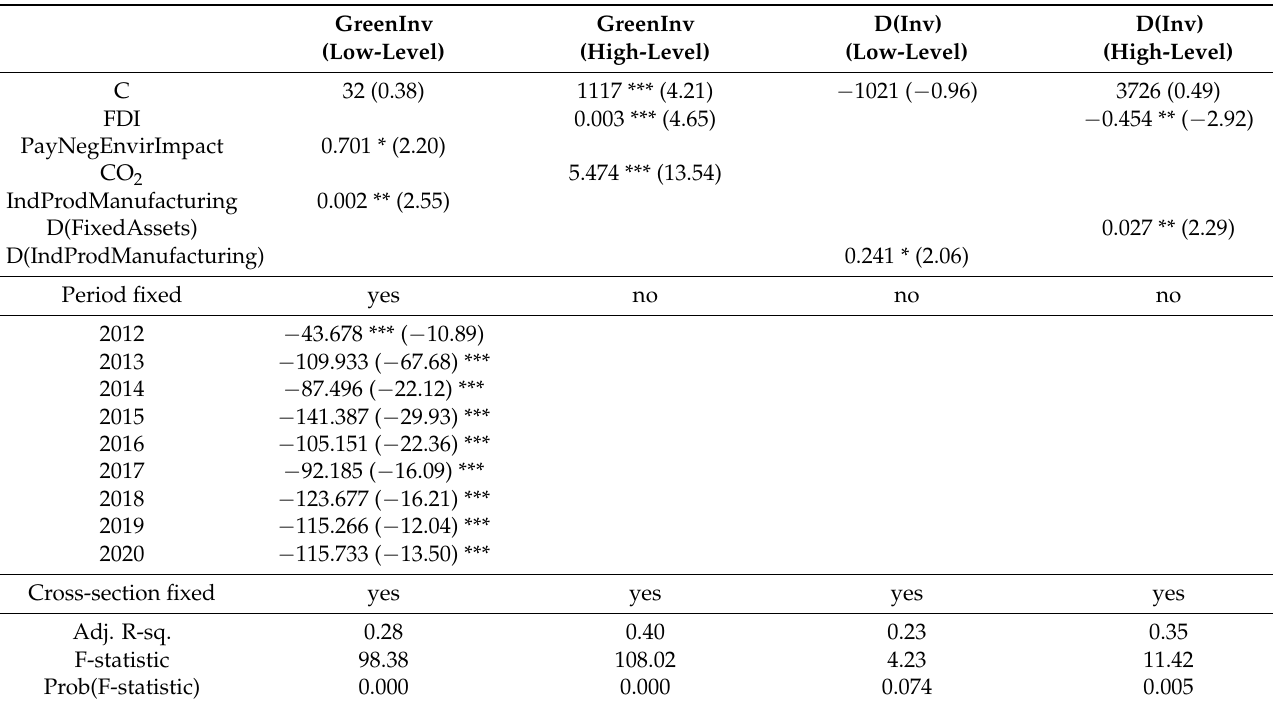
Table 6. Robustness test results (*** p < 0.01; ** p < 0.05; * p <